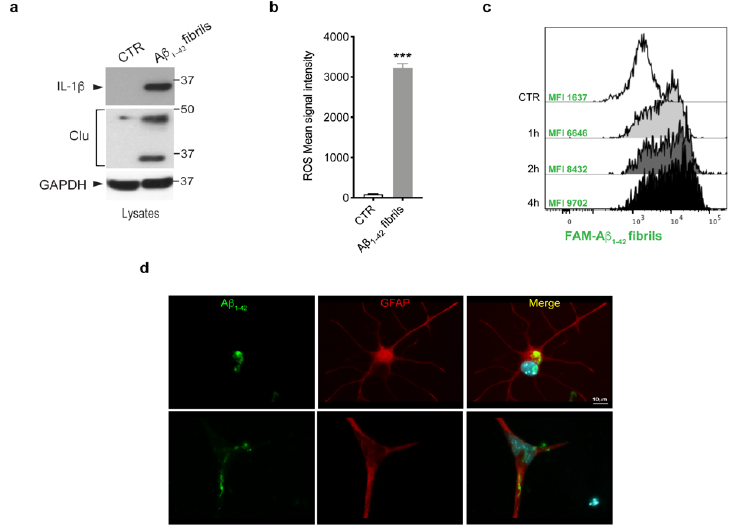
Figure 2 . Astrocytes activation upon A β 1 ‐ 42 fibrils. ( a ) Cell lysates of primary astrocytes treated with 10 μ M A β 1 ‐ 42 fibrils for 16 h, or with 10 mM ‐ DMSO HCl as a control, were subjected to immunoblotting using IL ‐ 1 β , clusterin (Clu) and GAPDH antibodies. Data are representative of several independent experiments (IL ‐ 1 β : n = 10, clusterin: n = 4). ( b ) ROS mean signal intensity was assessed in primary astrocytes exposed to 10 μ M A β 1 ‐ 42 fibrils for 16 h or to 10 mM ‐ DMSO HCl as a control. Data are representative of five independent experiments and are expressed as mean ± SEM. Data were analyzed using unpaired t -test, *** p < 0.0001. ( c ) Representative images of astrocytes exposed to A β 1 ‐ 42 fibrils for 2 h, fixed and immunostained for A β 1 ‐ 42 (green) and GFAP (red). Nuclei were stained with DAPI (blue). Scale bar 10 μ m.